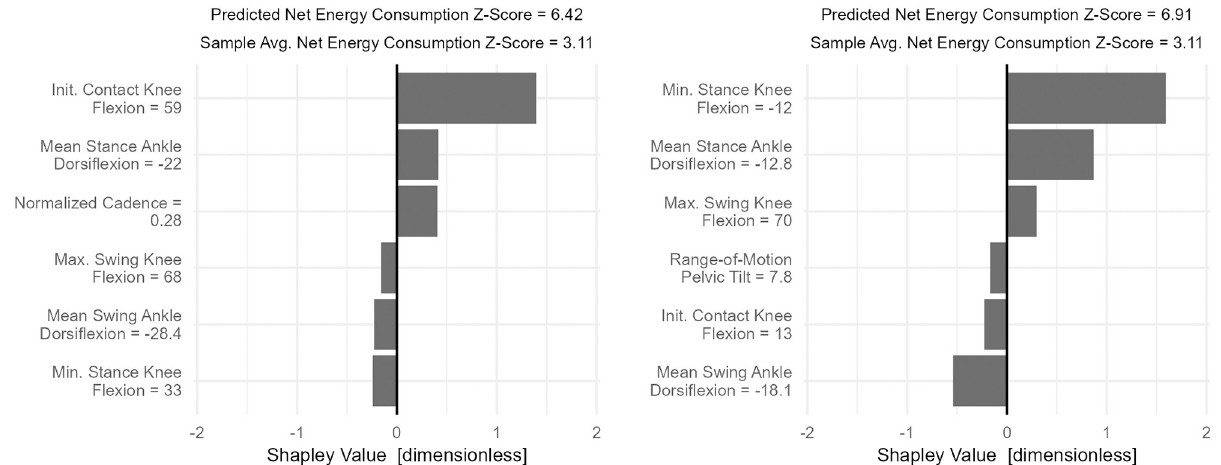
Fig 11. Case studies of Gait Mechanics effects on net energy consumption. The two individuals depicted have net energy consumption between 6 and 7 SD above speed-matched typically developing controls. For the individual on the left, initial contact knee flexion (59˚) is an important cause. The individual is in severe crouch (minimum stance knee flexion = 33˚)–yet this crouch lowers the net energy consumption. The hypothesized mechanism for this is described in the text. For the patient on the right, knee hyperextension and excessive ankle plantarflexion both contribute meaningfully to the elevated net energy